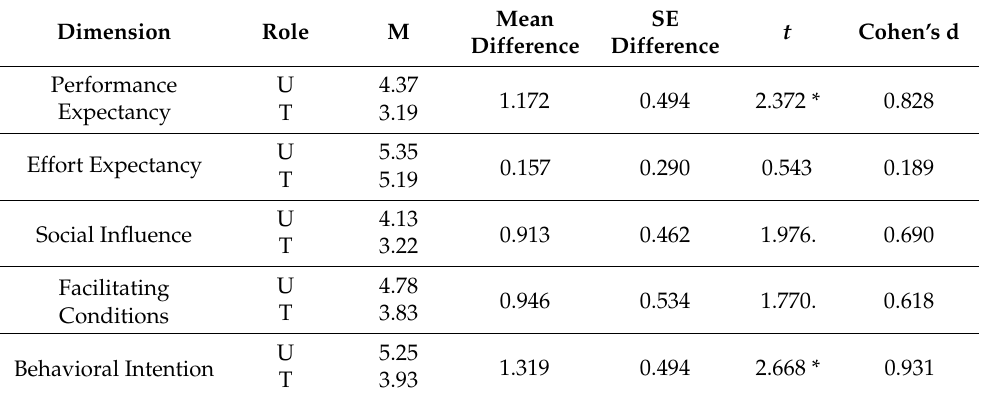
Figure 4. Evolution of the average incantation of U+ and T − responses per participant according to the measurement time (SHERPAM project). Table 3. Categorization Global evolution of the average dimensions of the UTAUT according to the role mobilized—SHERPAM project (Independent Samples t